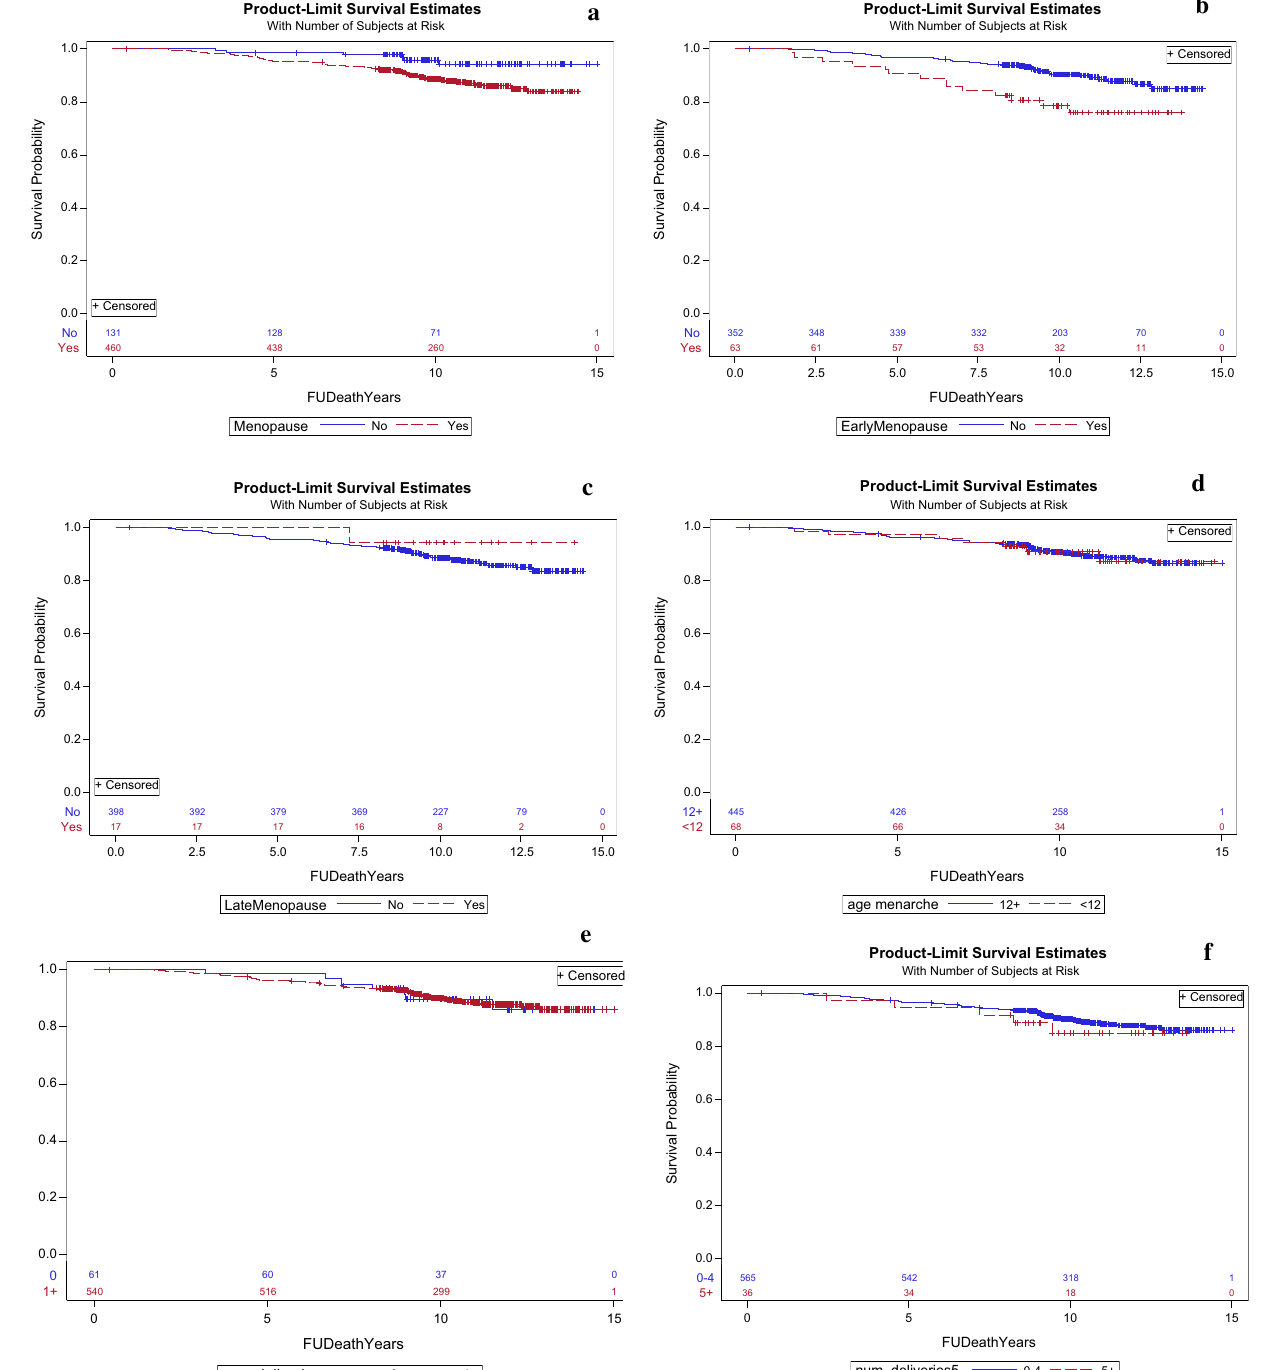
Fig. 2 Overall survival probabilities in a menopausal women, b early menopause (menopause before the age of 45), c late menopause (menopause older the age of 55), d early age at menarche (menarche before the age of 12), e nullipara f number of deliveries (0–4 vs. 5 and more), g age at first live birth (30 years and older vs. < 30